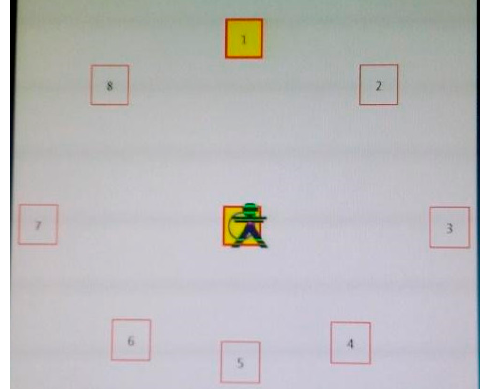
Figure 2. Limits of the stability test procedure.